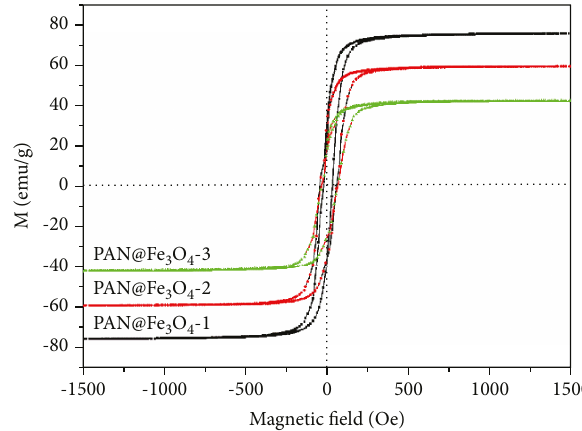
O and PAN@Fe 3 4